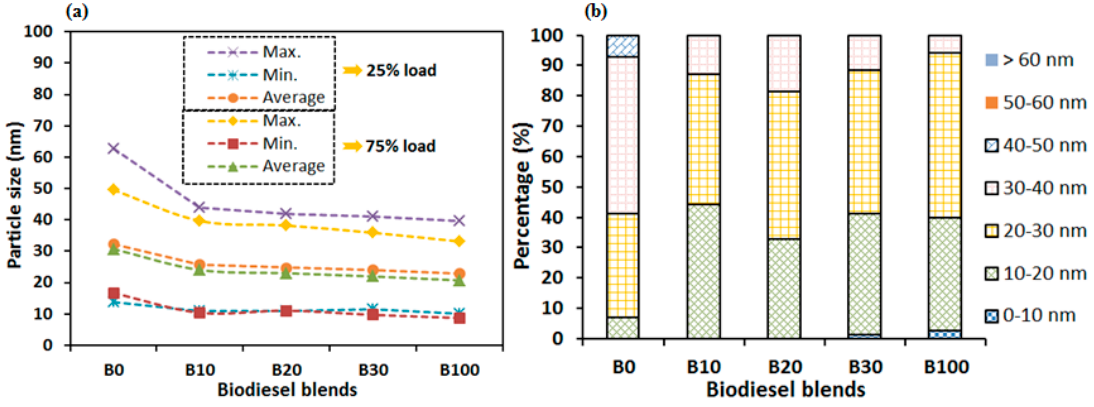
Figure 10. PM primary particle size ( a ) and its distribution at 75% engine load ( b ).